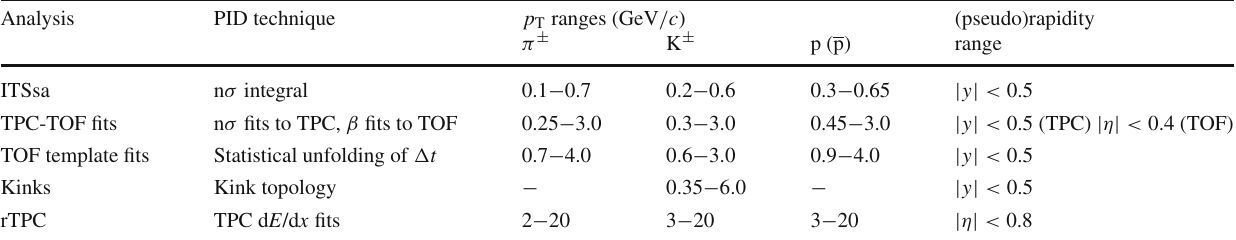
Table 2 Different p T ranges used for the identification of pions, kaons and protons. The final p T spectra have been obtained by combining the results of the various PID techniques